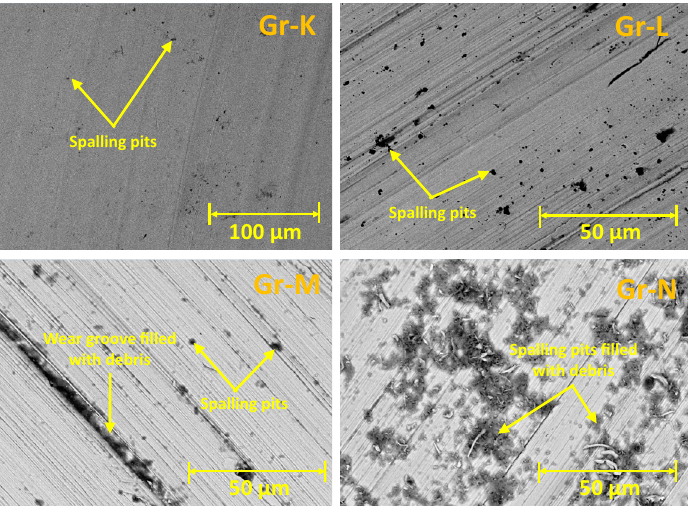
Figure 10. SEM images of antagonist (stainless steel ball) wear surface for Rotary Test (Groups K-N): No Fibre, 5% 50 AR, 5% 70 AR and 5% 100 AR, showing an increase in the spalling pit area with the increasing fibre